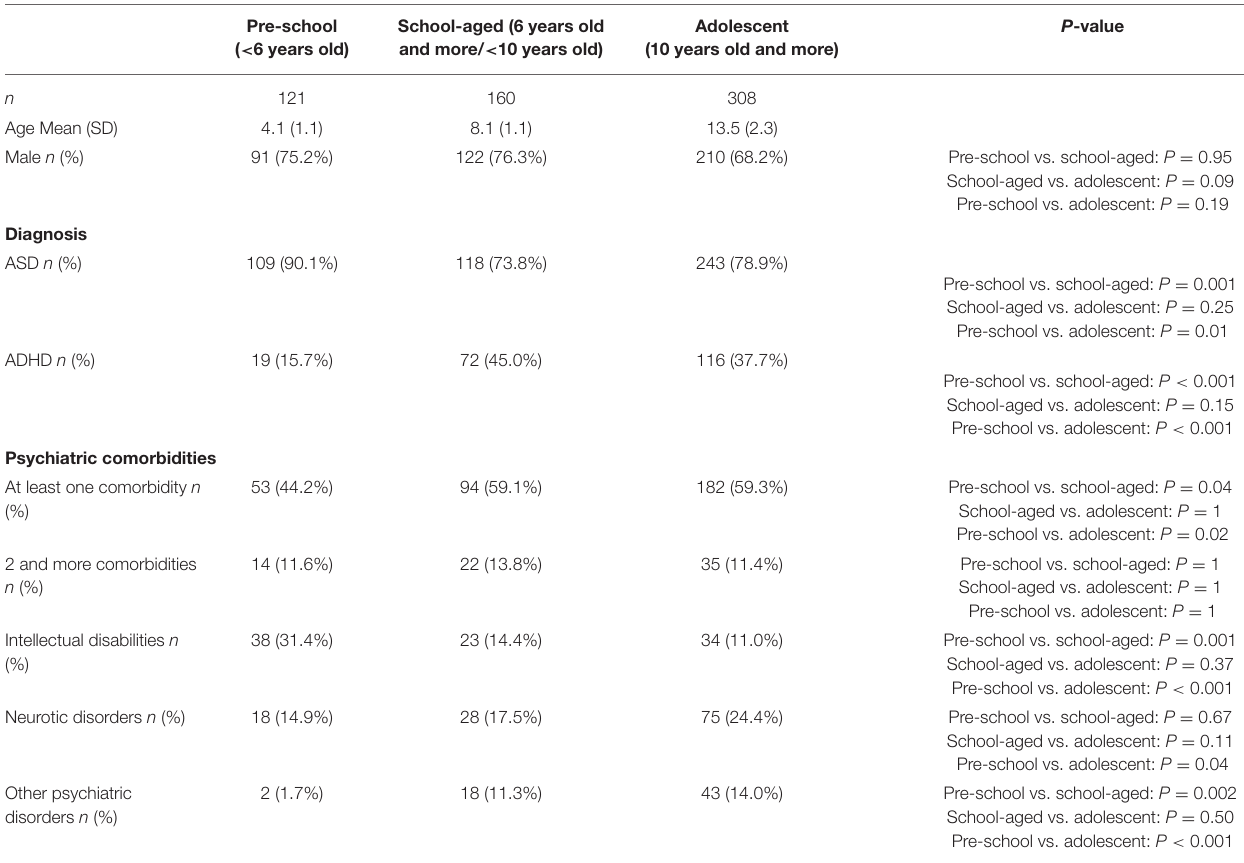
TABLE 1 | Demographic and clinical background of participants in each